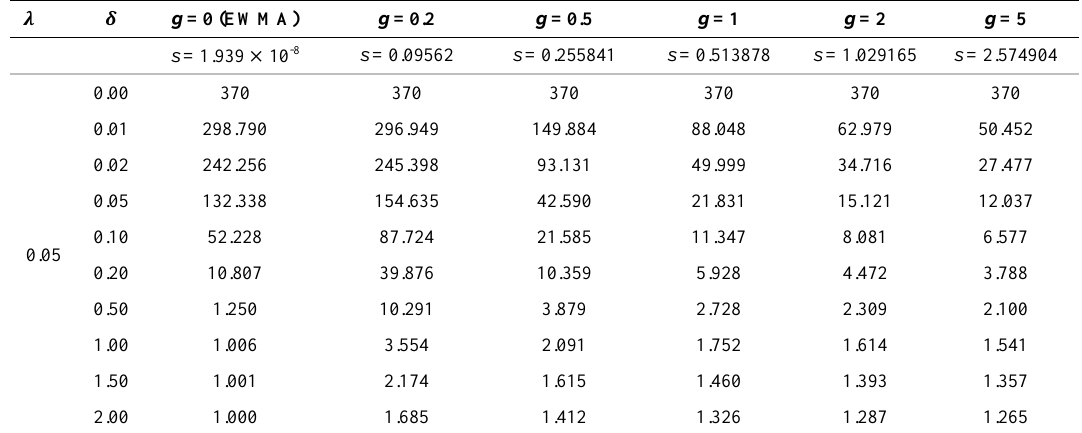
Table 3. Compare the modified EWMA chart on the FIMA (1/2,2) model at various λ and g given 𝜽 𝟏 = 0.05, 𝜽 𝟐 = 0.10, r =